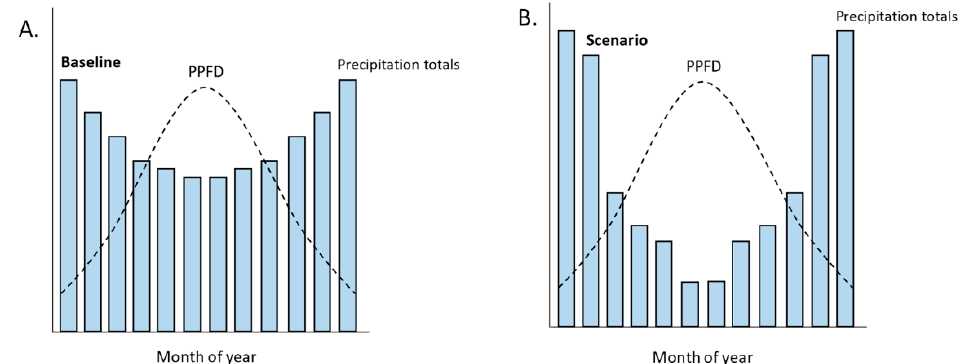
Figure 3. Graphic to demonstrate the potential for nonanalogue climates. Graphs ( A. ) (baseline) and ( B. ) (scenario) have the same annual total precipitation for a theoretical study site but distributed differently throughout the year; this can generate a contrasting relationship between precipitation totals and number of rain-days as alternative predictors of moisture availability. Furthermore, monthly precipitation totals have a different relationship with the solar cycle of photosynthetic photon flux density (PPFD) when comparing ( A. ) with similar moisture availability for low and high light periods and ( B. ) with higher moisture during a low light, and lower moisture during a high light period. Considering alternative interacting covariables such as light availability opens up the wide potential for nonanalogue climates, as future climate change is expected to shift moisture patterns seasonally, monthly and with respect to annual solar cycles.